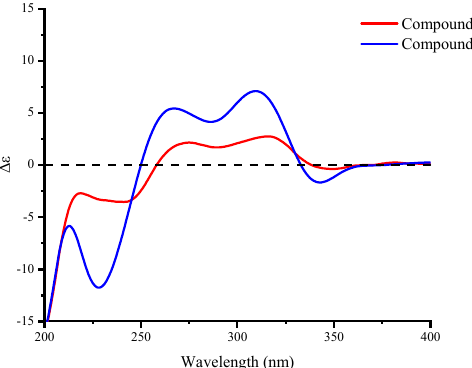
Figure 3. ORTEP drawing of 1.